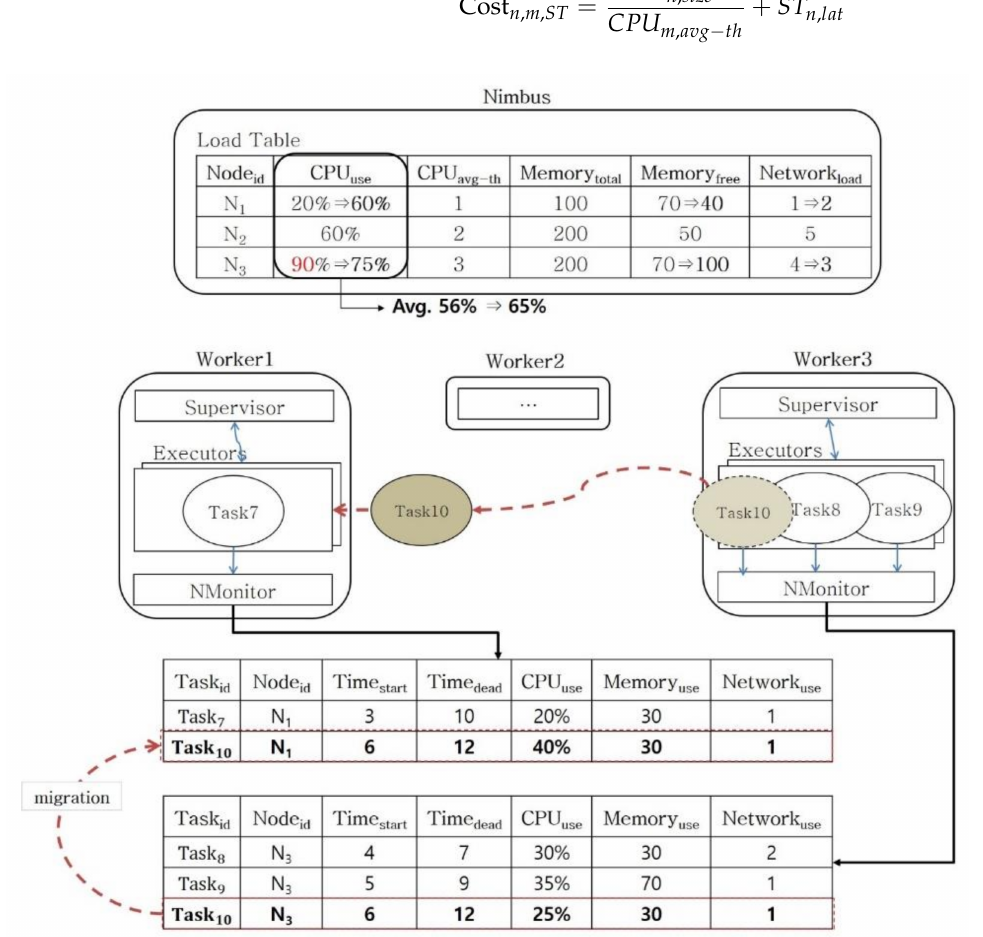
Figure 5. CPU load-based